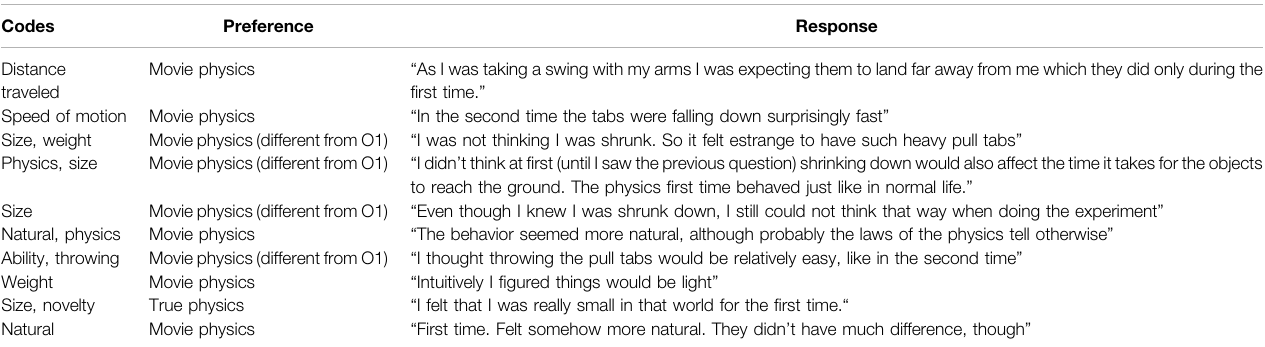
TABLE 2 | Examples of O2 responses (justi fi cation to expectations ) in Study 1. Codes